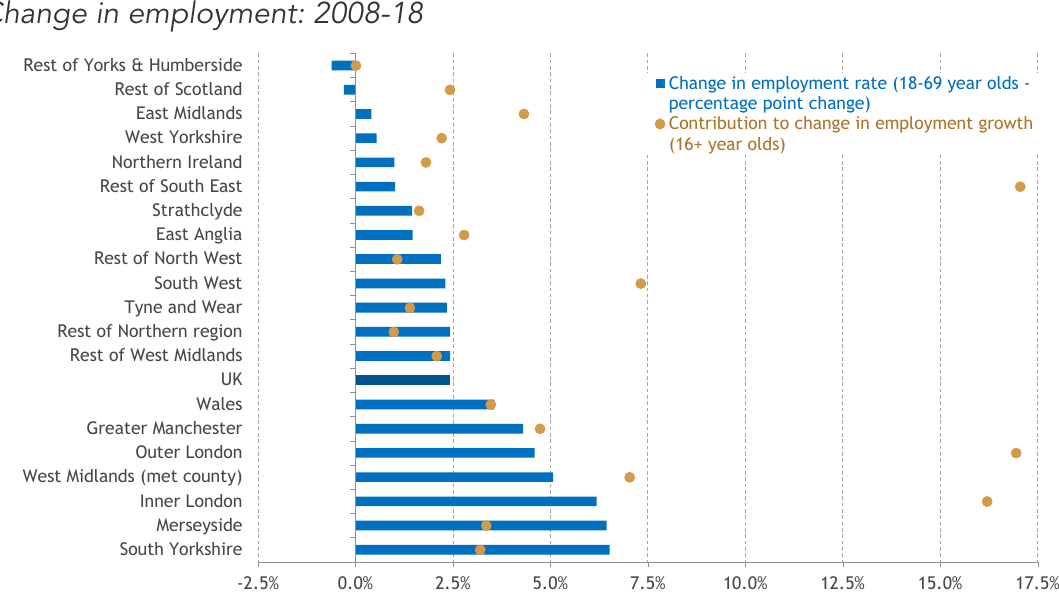
Figure 14: Employment rates have risen across the country Change in employment: